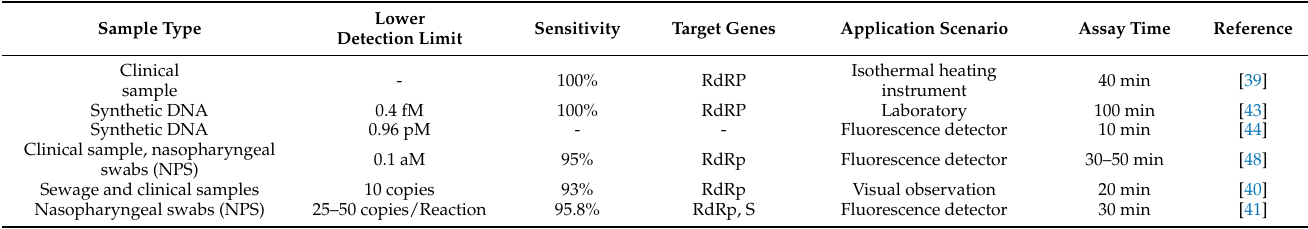
Table 2. The data and applications of off-chip isothermal amplification detection technology were